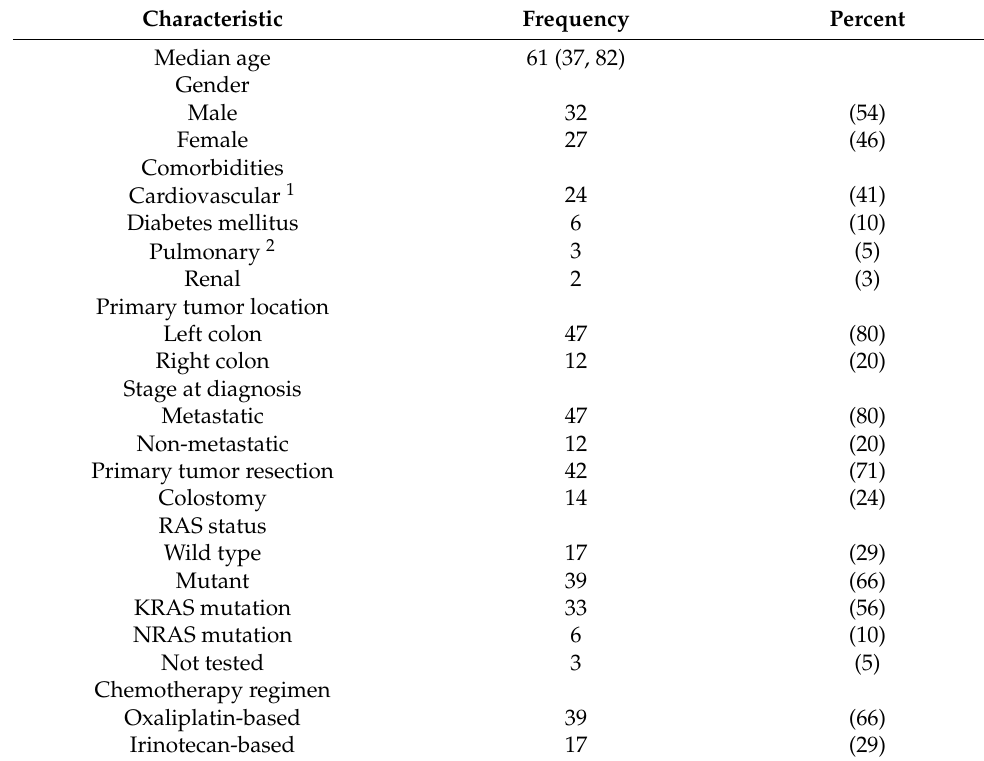
Table 1. Patient and disease